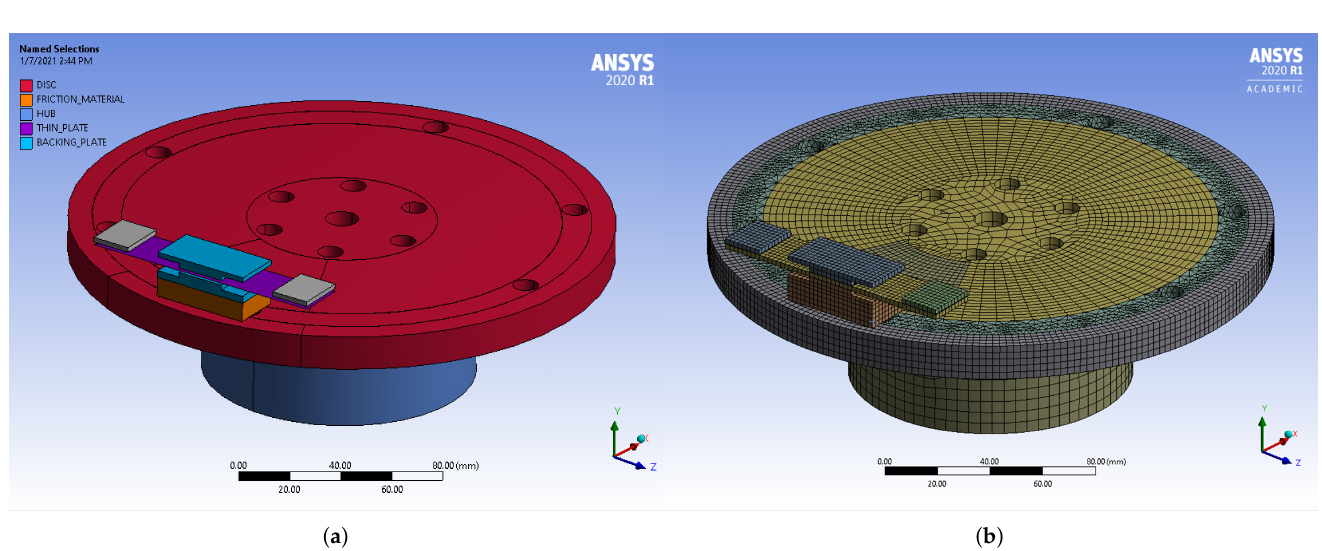
Figure 7. ( a ) Geometry of the simplified pad-on-disc brake model, ( b ) FEM representation of the model counting 75,520 elements and 184,225